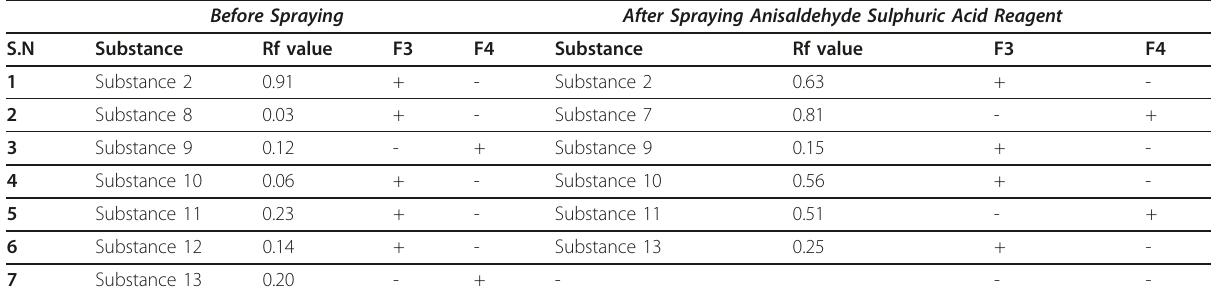
Table 2 Analysis for presence of unique substances in fraction F3 and F4 before and after spraying anisaldehyde sulphuric acid